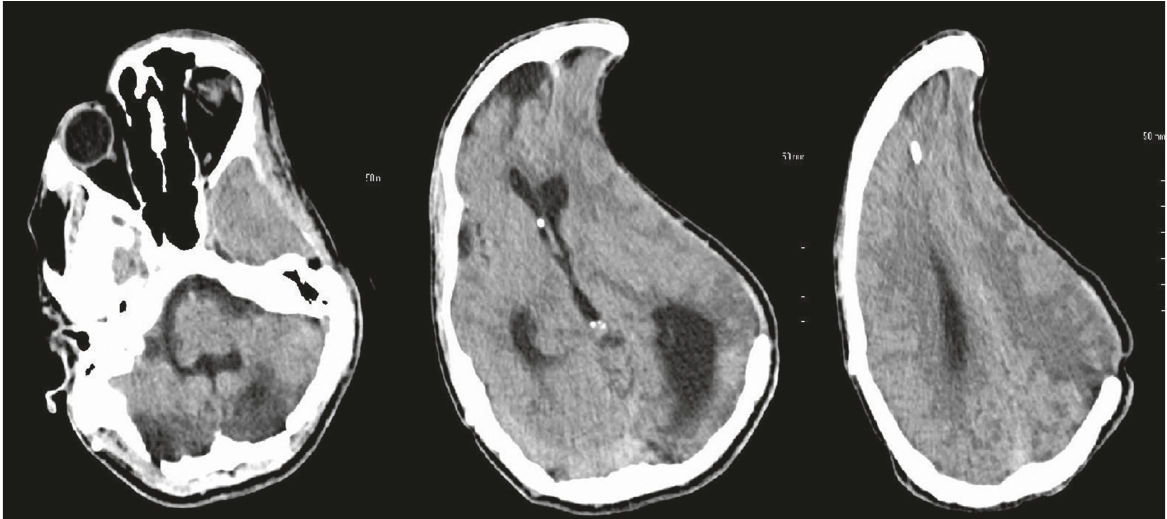
Figure 2: Head CT revealing left-sided prior craniectomy with improved midline shift as compared to Figure